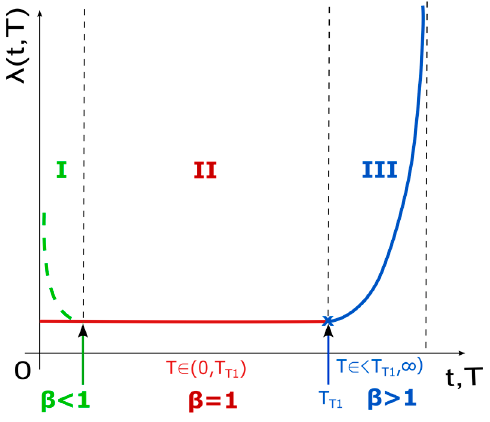
Figure 5. Bathtub curve.